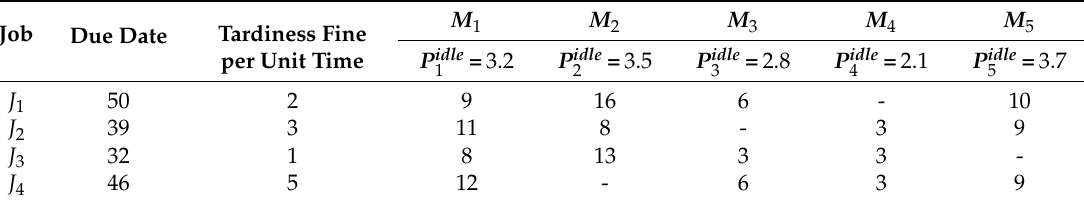
Table 1. The basic data in case 1 (4 jobs × 5 machines).